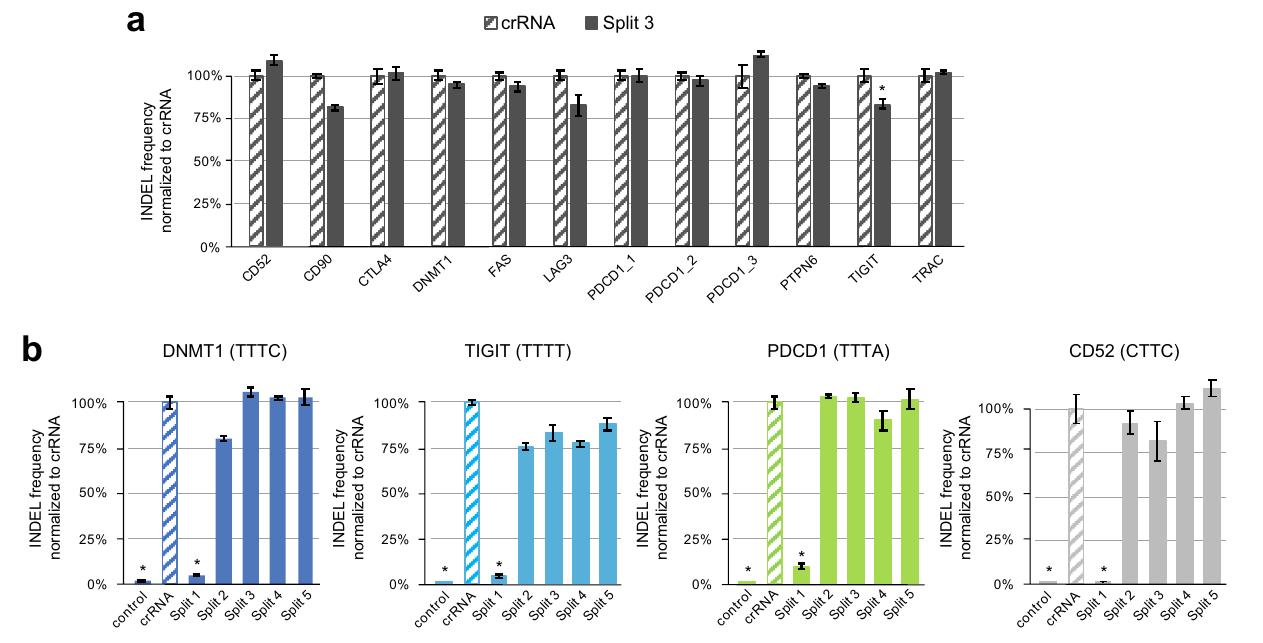
Figure 2. SynThetic trAcer RNAs (STARs) editing efficiency at immunologically important target sites. ( a ) INDEL frequency (%) of MAD7 with wild-type crRNA and Split 3 STAR-crRNA targeting twelve selected loci, measured by amplicon sequencing (error bars: mean ± SEM for n = 6). Unnormalized INDEL frequency (%) data are presented in Supplementary Fig. 2a. ( b ) INDEL frequency (%) of MAD7 with wild-type crRNA and Split STAR-crRNAs targeting the DNMT1, TIGIT, PDCD1, and CD52 loci with different PAM sequences (TTTC, TTTT, TTTA, and CTTC respectively), measured by amplicon sequencing (error bars: mean ± SEM for n ≥ 3). Unnormalized INDEL frequency (%) data are presented in Supplementary Fig. 2b. All samples showing significant changes in INDEL frequencies compared to wild-type crRNAs, P ≤ 0.05 using two-sided t -test after a global one-way analysis of variance (ANOVA), are indicated with asterisk. The sequences of all crRNAs used are listed in Supplementary Table